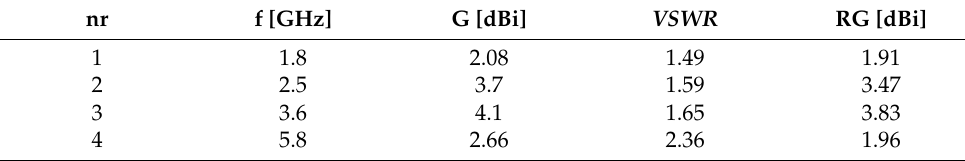
Table 4. Parameters of optimized single circle